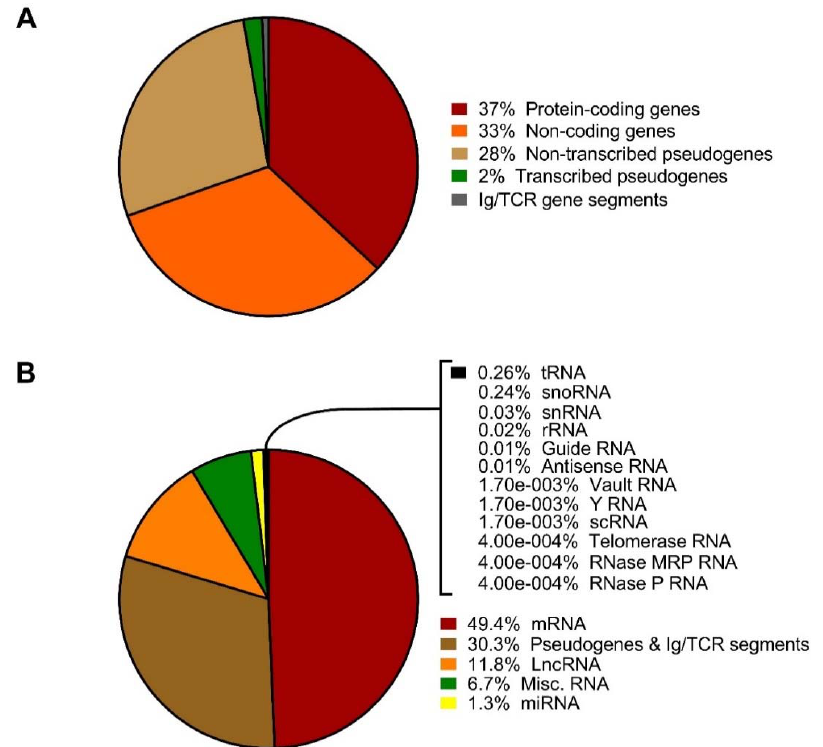
Figure 2. Pie charts showing the percentage of ( A ) the different genes and ( B ) different RNA types from the human reference genome (GRCh38.p12) following the RefSeq annotation assembly. The annotations are available from the genome database part of the NCBI database, and the data depicted above are from the Annotation Release 109 (https://www.ncbi.nlm.nih.gov/search/?term=human+genome